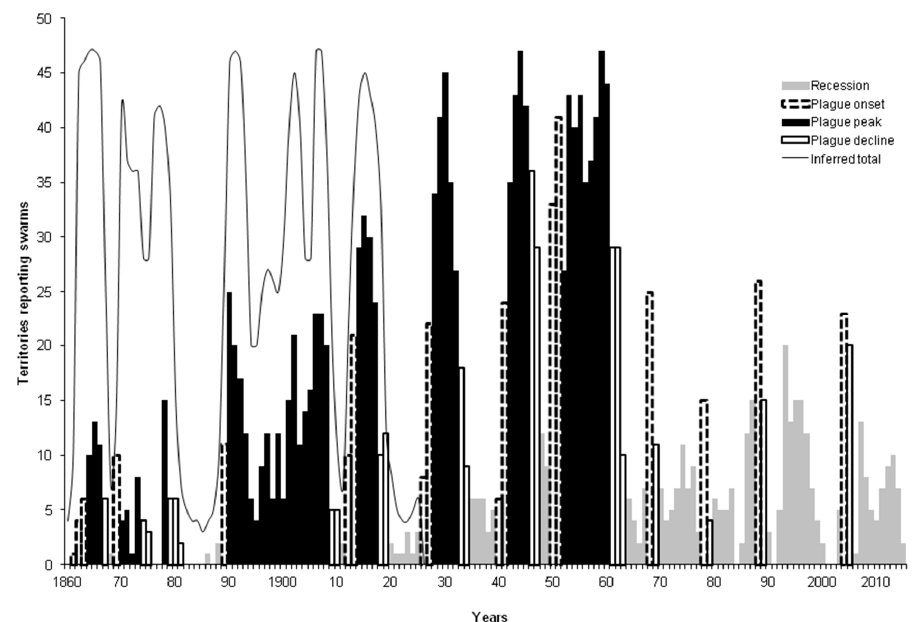
Figure 1. Numbers of territories as defined by Waloff (1976) [24] infested with swarms of the Desert Locust 1860 to 2015 inclusive. The solid line represents the inferred time series for 1860 to 1925 (see text), grey areas are recession periods, the dashed line depicts periods of plague onset, solid black lines indicate plagues and open bars show periods of plague